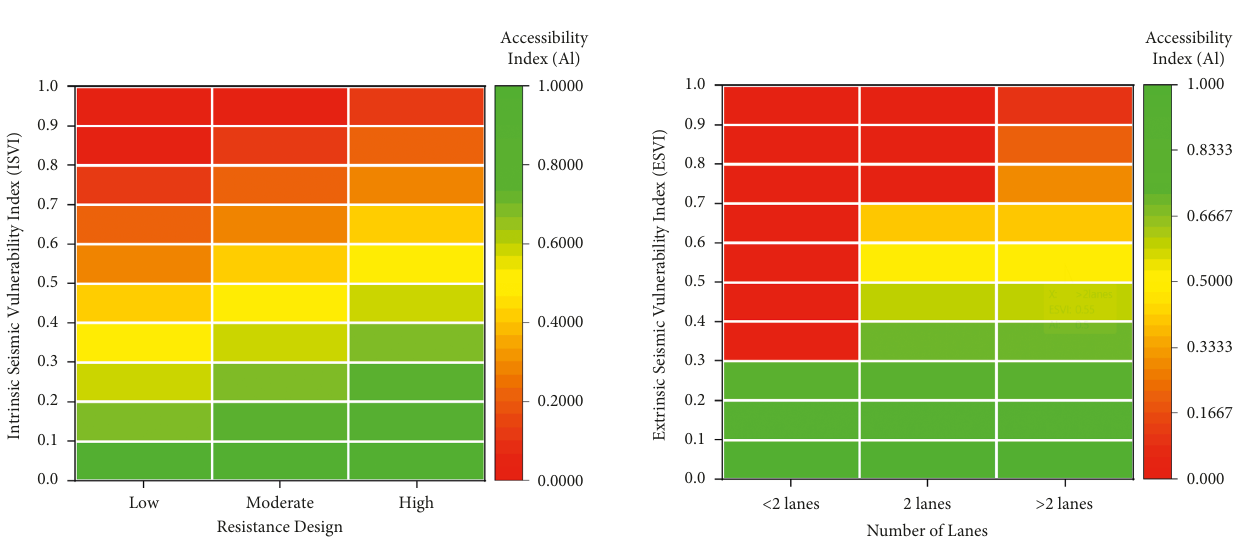
Figure 18: Integrated accessibility heat map between the ESVI and road width of the road for the assessment of ESV.